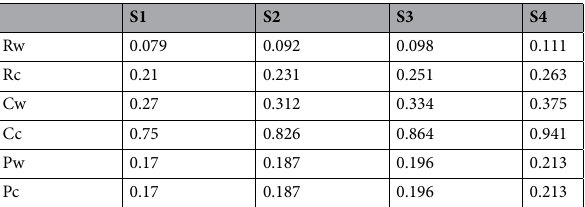
Table 7. Leakage of heavy metals in scenarios (μg/m 2 ). Rw = Residential areas in warm